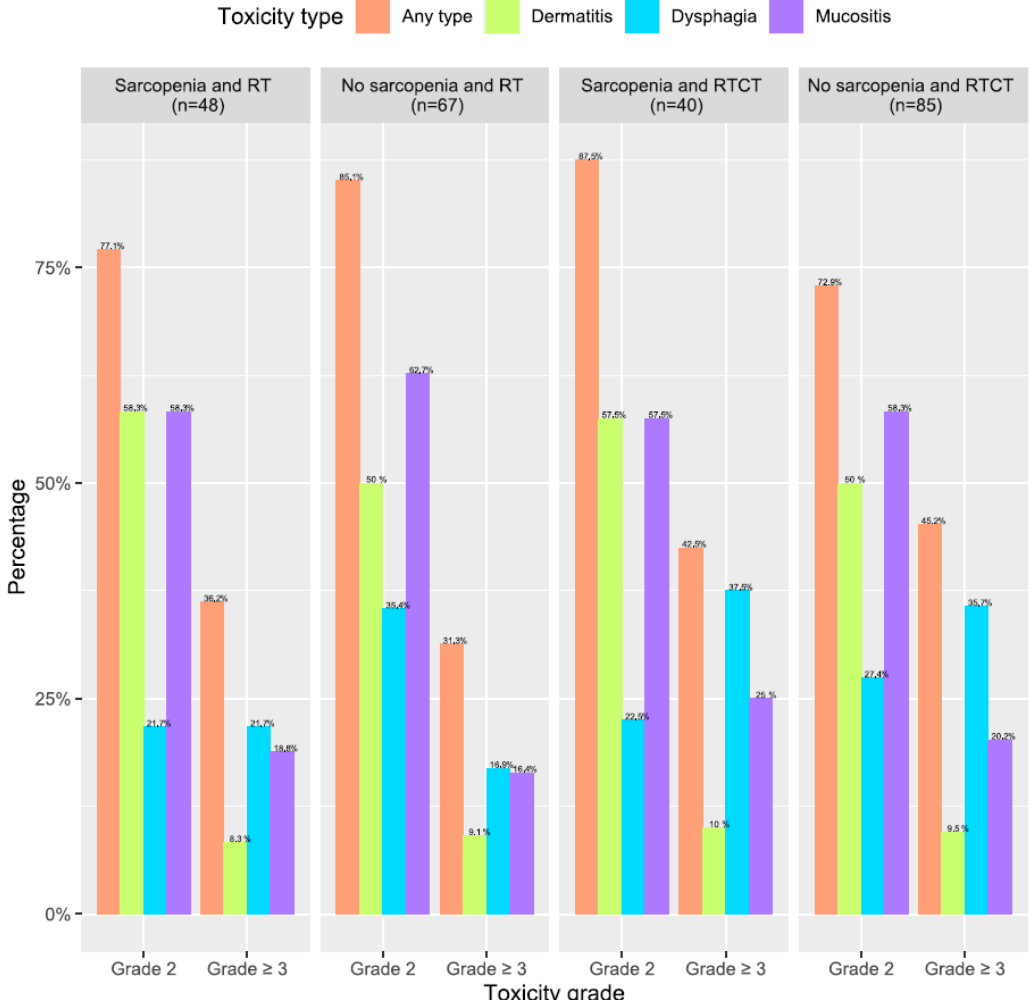
Figure 2. Percentages of patients with grade 2 or grade 3 acute toxicities according to sarcopenic status and treatment. The “any type” column represents the percentage of patients with at least one type of toxicity. The same patient could have several types of grade or 3 toxicities.